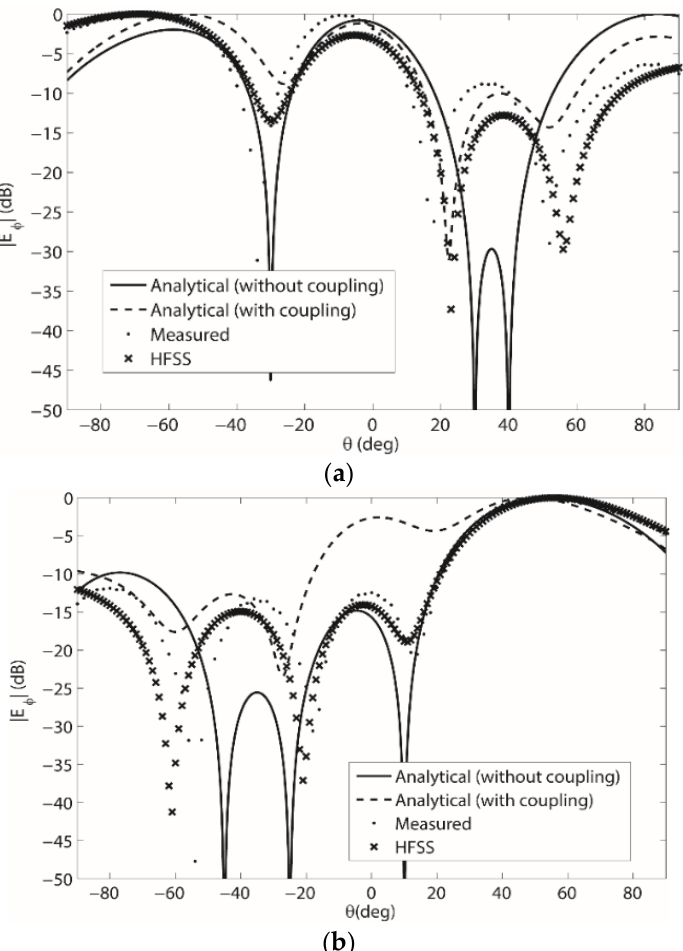
Figure 7. ( a ) Pattern 1 beamforming results for the 1 × 4 microstrip patch array on the singly curved (wedge-shaped) surface with θ b = 45 ◦ ; and ( b ) Pattern 2 beamforming results for the 1 × 4 microstrip patch array on the singly curved (wedge-shaped) surface with θ b = 45 ◦